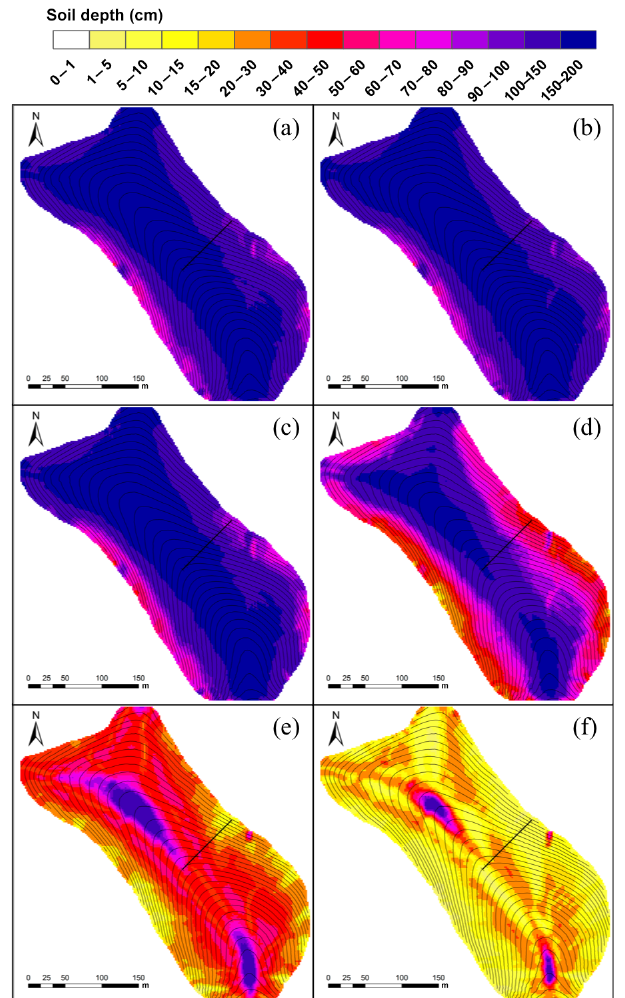
Figure 4. Soil depth maps produced by the fluvial-only simula- tion (S1) at 3.2kyr time intervals in the last 18 of 80kyr simu- lated: (a) 18kyrBP, (b) 12.8kyrBP (end of P1), (c) 9.6kyrBP, (d) 6.4kyrBP (end of P2), (e) 3.2kyrBP, and (f) 0kyrBP (fi- nal/modern end of P3). The contour lines represent 2 m change in